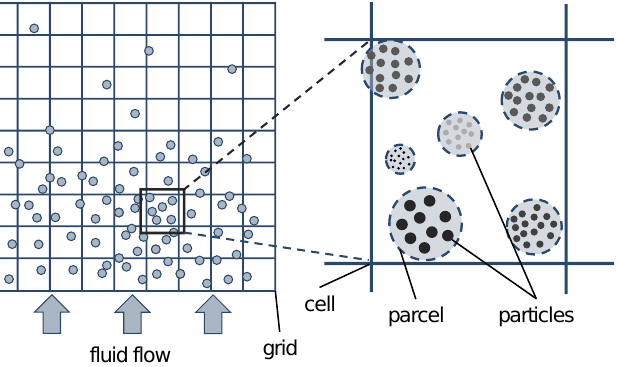
Figure 2. Schematic representation of the MP-PIC method adapted from Solnordal et al.